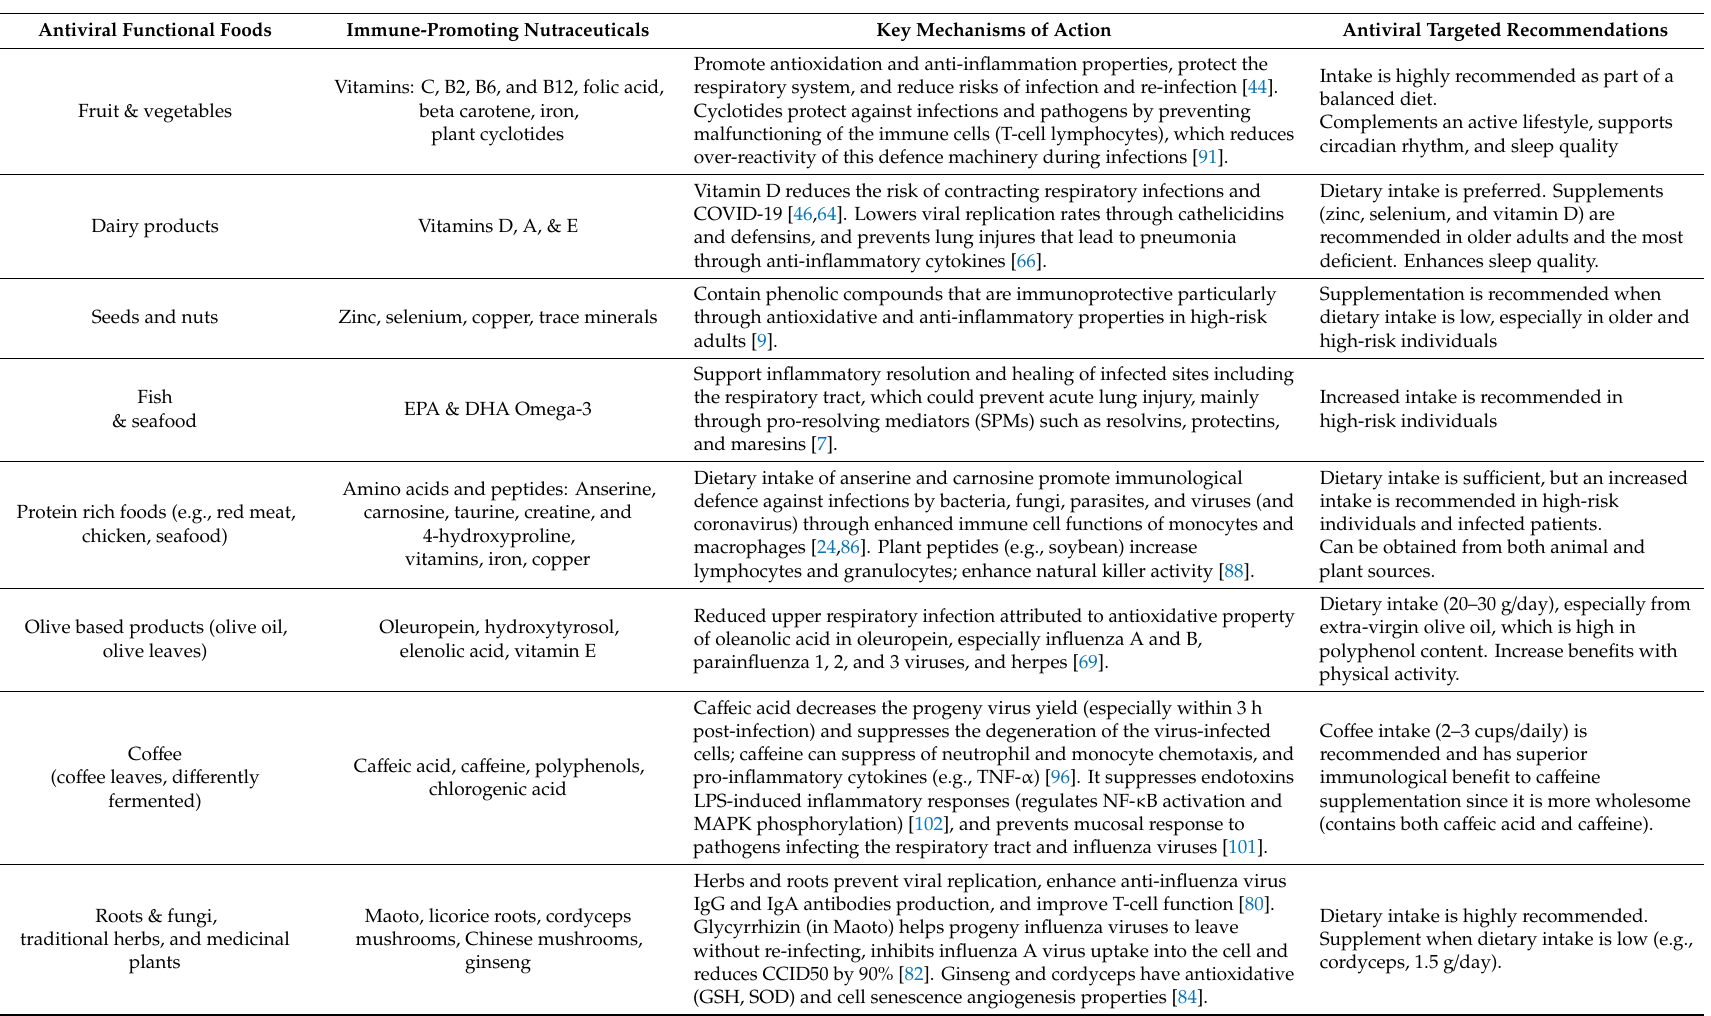
Table 1. Antiviral functional foods, their immune protective nutraceuticals, mechanisms of action, and recommended